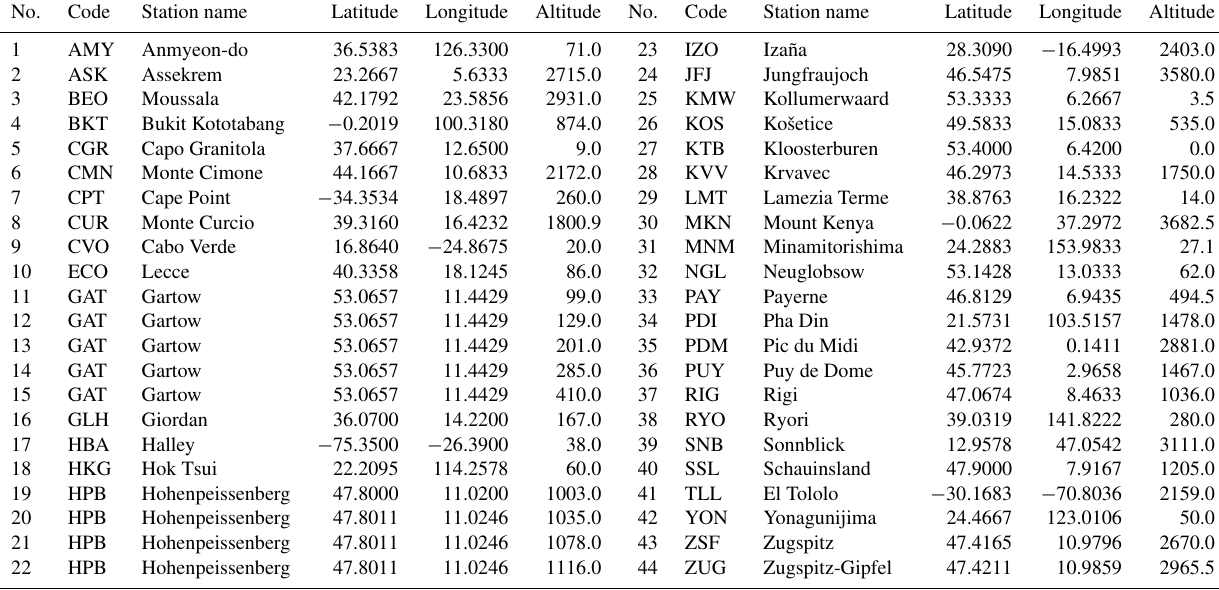
Table A2. Information about GAW surface sites used in this study. The altitude is given in meters above sea level. No.